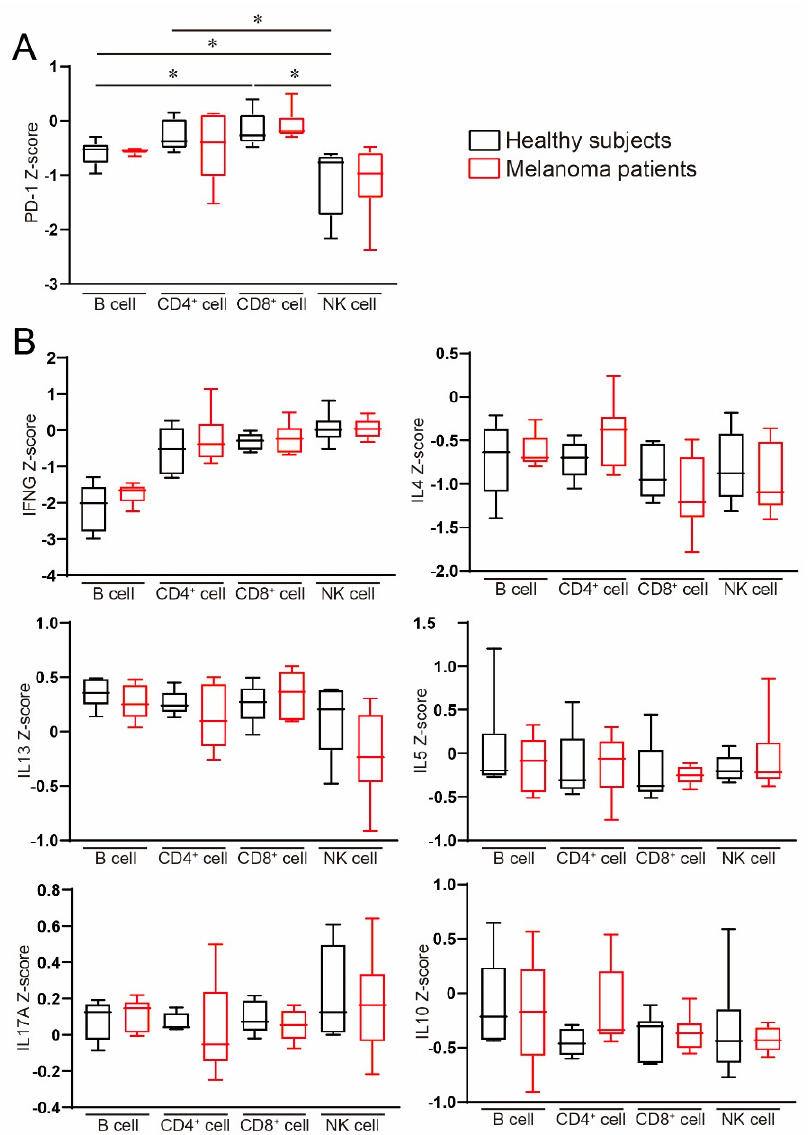
Figure 2. Gene expression in peripheral blood immune cell subsets. RNA-seq data set analysis in peripheral blood immune cells in healthy subjects and melanoma patients. ( A ) PD-1 and ( B ) in- flammatory cytokines were evaluated. Results are expressed as the mean ± SE. All p -values were obtained by Student’s t test: *, p < 0.05.